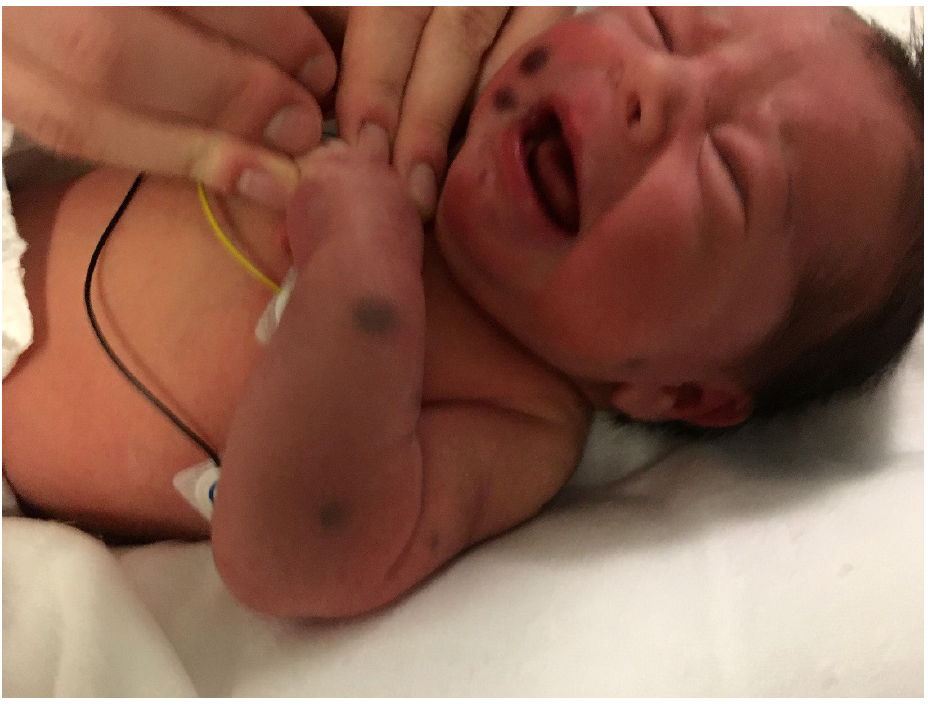
Figure 1. Blueberry muffin rash. Table 1. Causes of blueberry muffin rash.